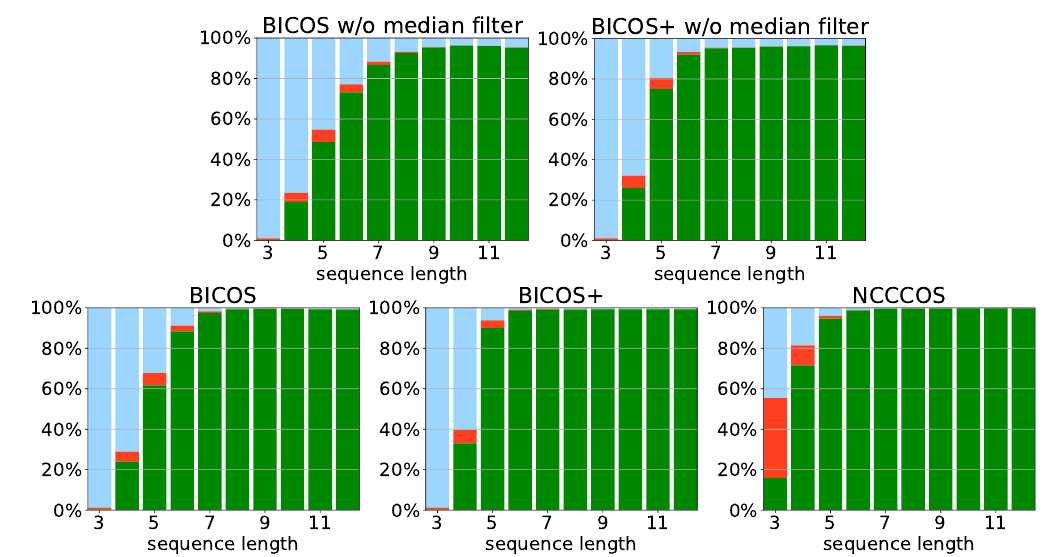
Figure 14. Quality of coarse correspondence search: green: percentage of correctly found correspondences, red: percentage of incorrectly found correspondences, blue: percentage of not found correspondences.